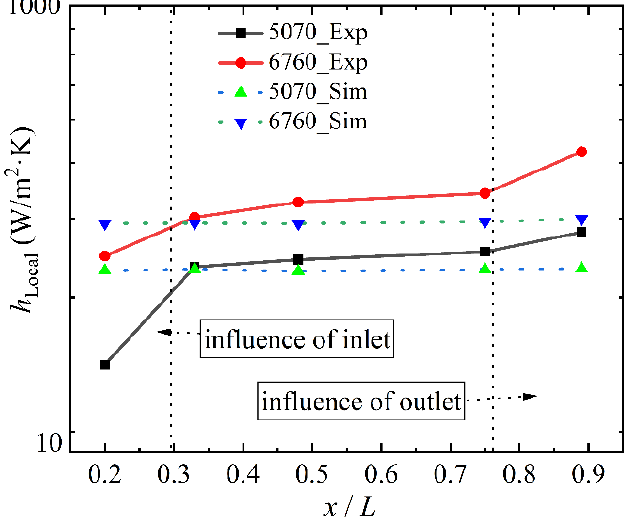
Figure 6. The comparison of the local heat transfer coefficient between the experiment and simula- tion.